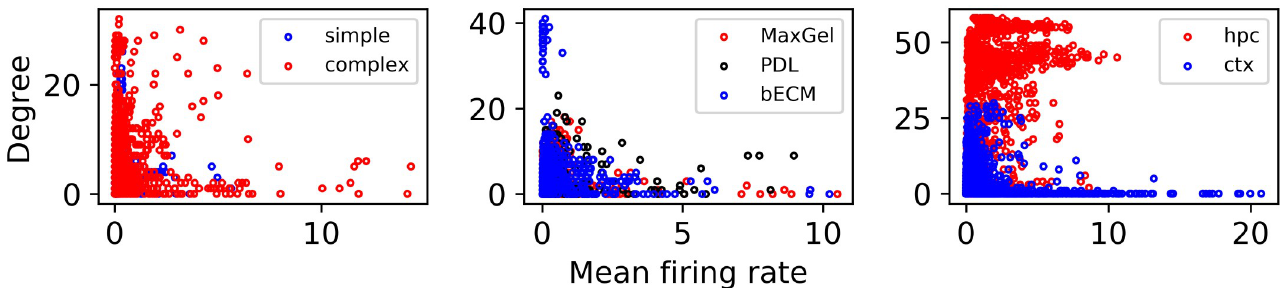
Fig 11. Mean firing rate compared to the degree of the nodes in our networks. Connectivity cannot be merely explained by the level of activity in an electrode.